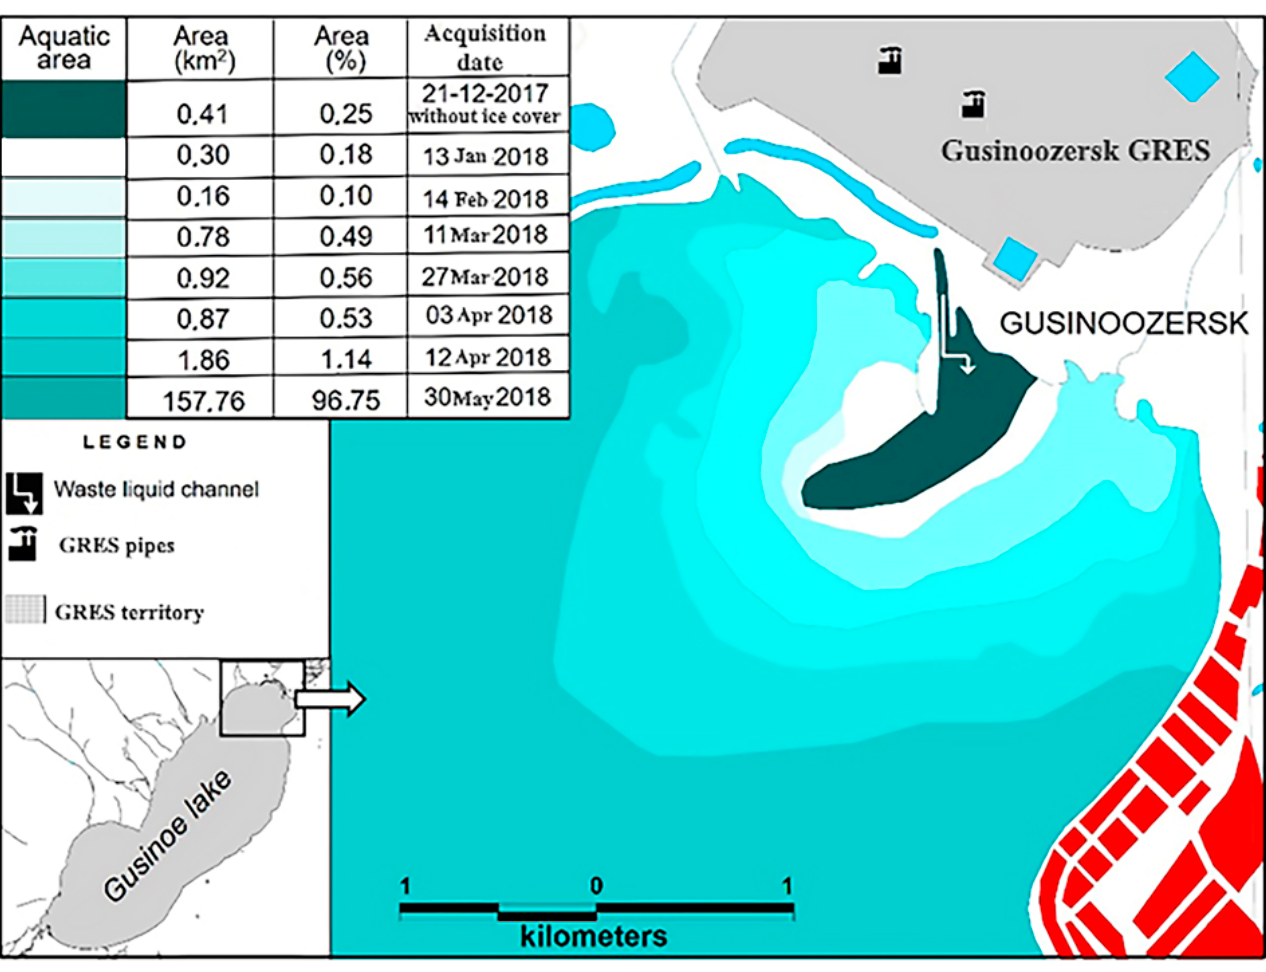
Figure 2. Ice regime of the lake near the GRES.